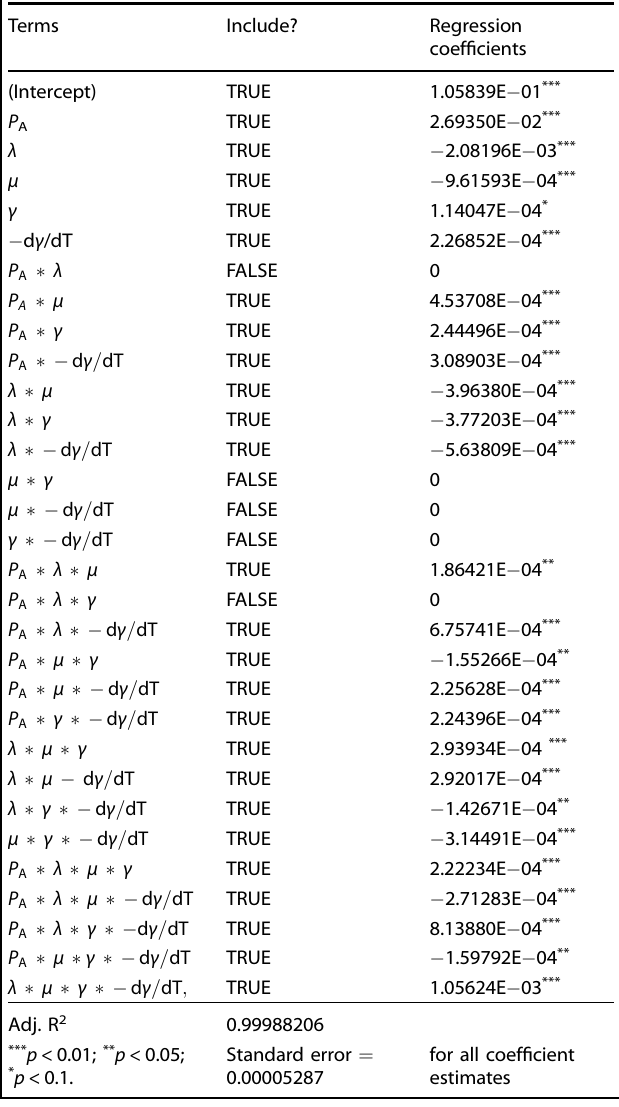
Table 2. Best subset model regression coef fi cients and p values of selected variables using a signi fi cance level of 0.1.